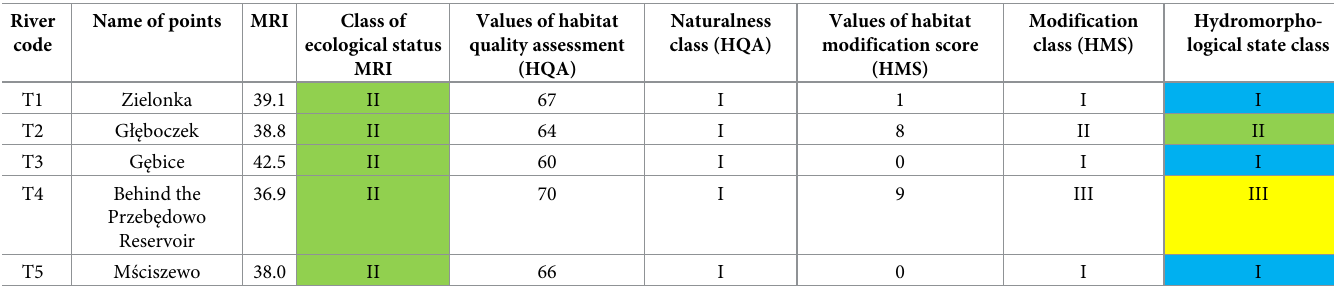
Table 4. Macrophyte and hydromorphological indicators of the analysed sections of the Trojanka River based on the MMRA and RHS methods. River Name of code